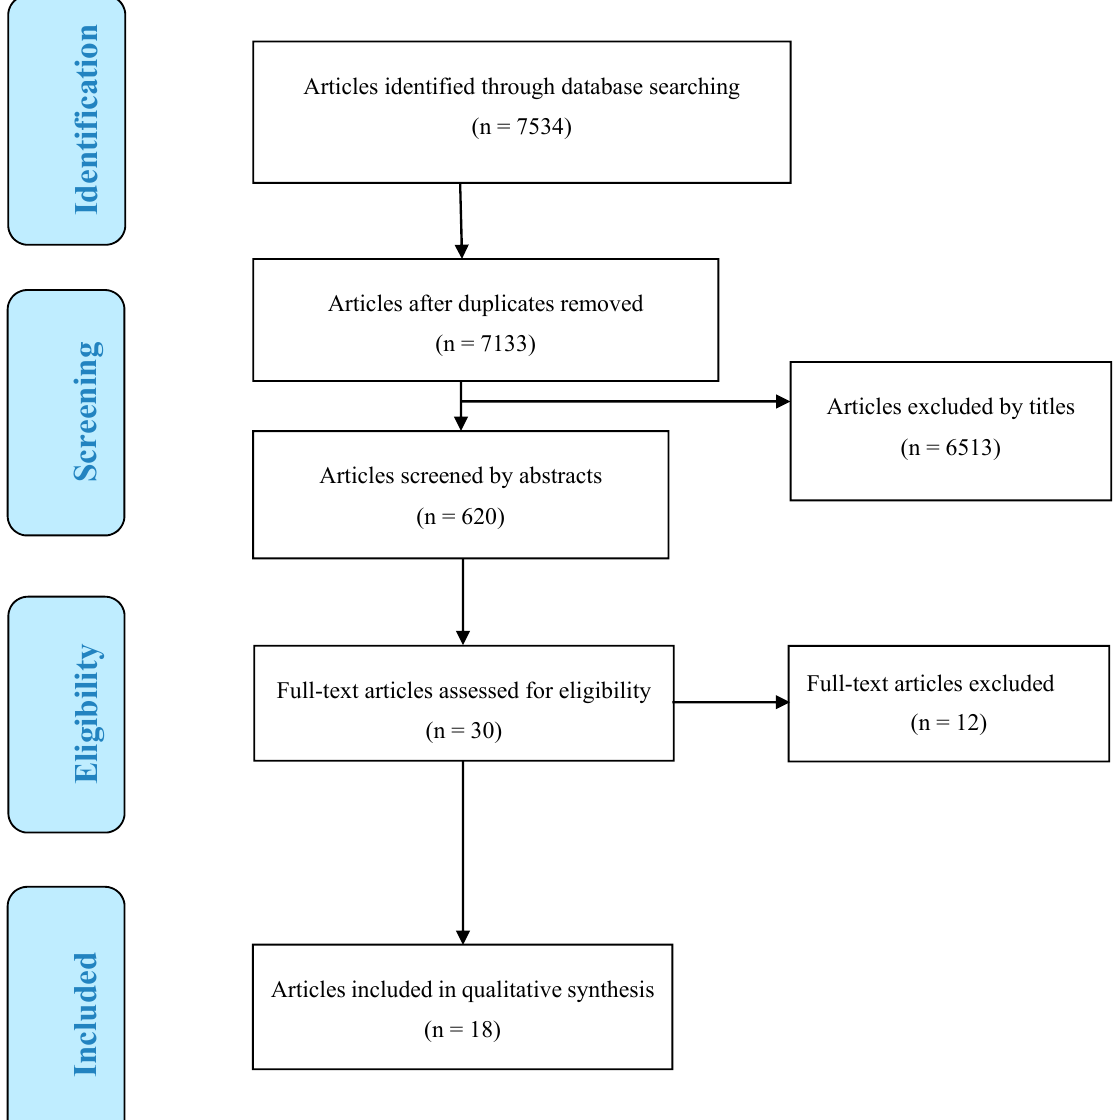
Figure 1. PRISMA flow diagram for literature search.